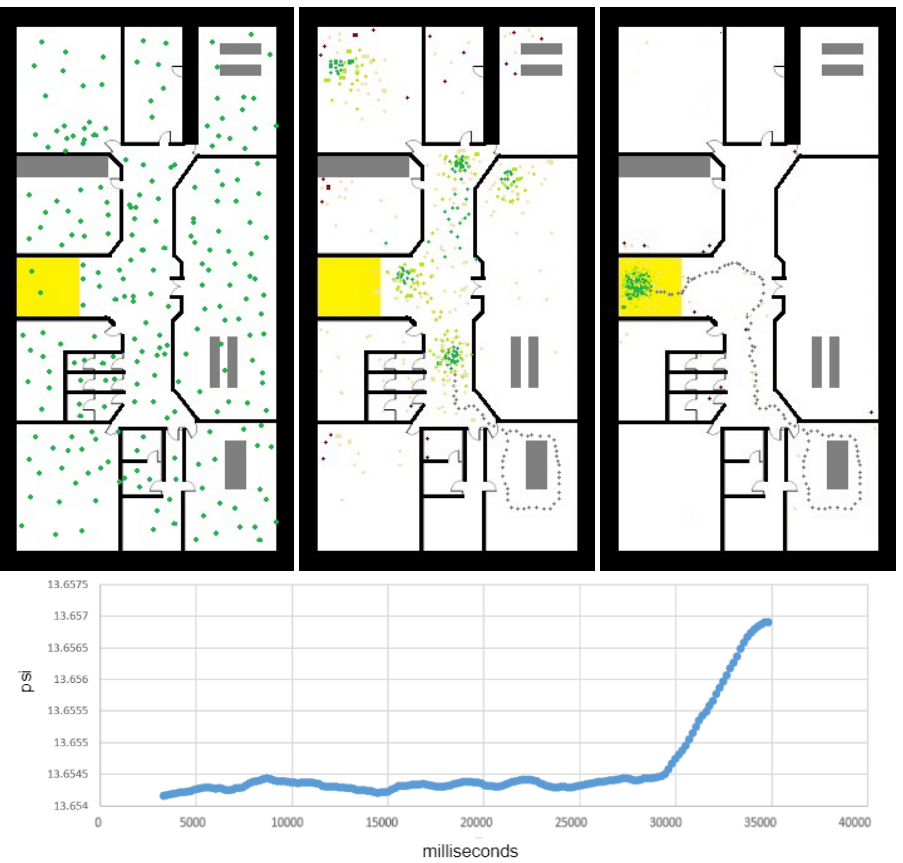
Figure 4. Particle filter for localization. ( Left ): Init state, the particles are uniformly distributed. ( Center ): using the short motion vector, the particles are beginning to organize into a few clusters. ( Right ): the particles converge to a single position cluster, mainly due to floor-change detection. The lower graph shows the barometer raw measurements ( PSI ) in time. The peak in the PSI measurements corresponds to the 3 m change between the two floors. The detection of floor change allowed the algorithm to converge efficiently to the right 3 D